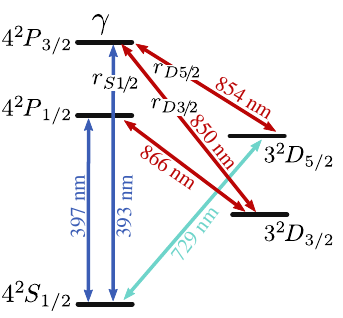
FIG. 6. 40 Ca + level scheme with branching ratios and addi- tional transitions used for cooling. Total decay of P 3 / 2 [39]: γ/ 2 π = 11.49 ( 3 ) MHz. Branching ratios [61]: r D 1 / 2 =